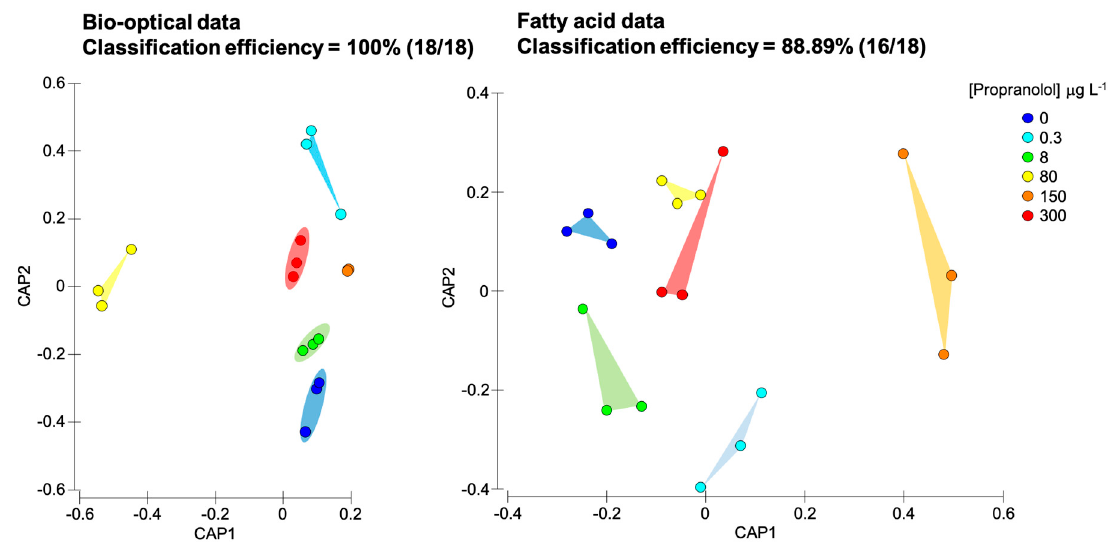
Figure 10. Canonical analysis of principal (CAP) components of the bio-optical and fatty acids profiles obtained from the analysis of Phaeodactylum tricornutum cultures exposed to the different propranolol concentrations.